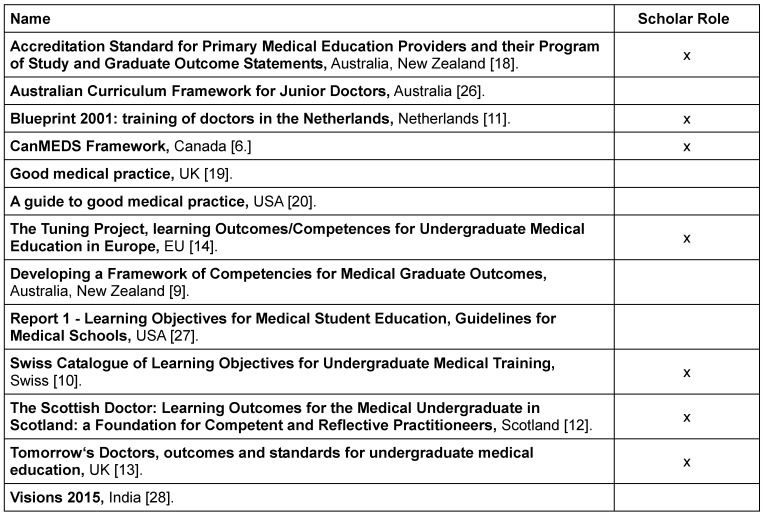
Frameworks included